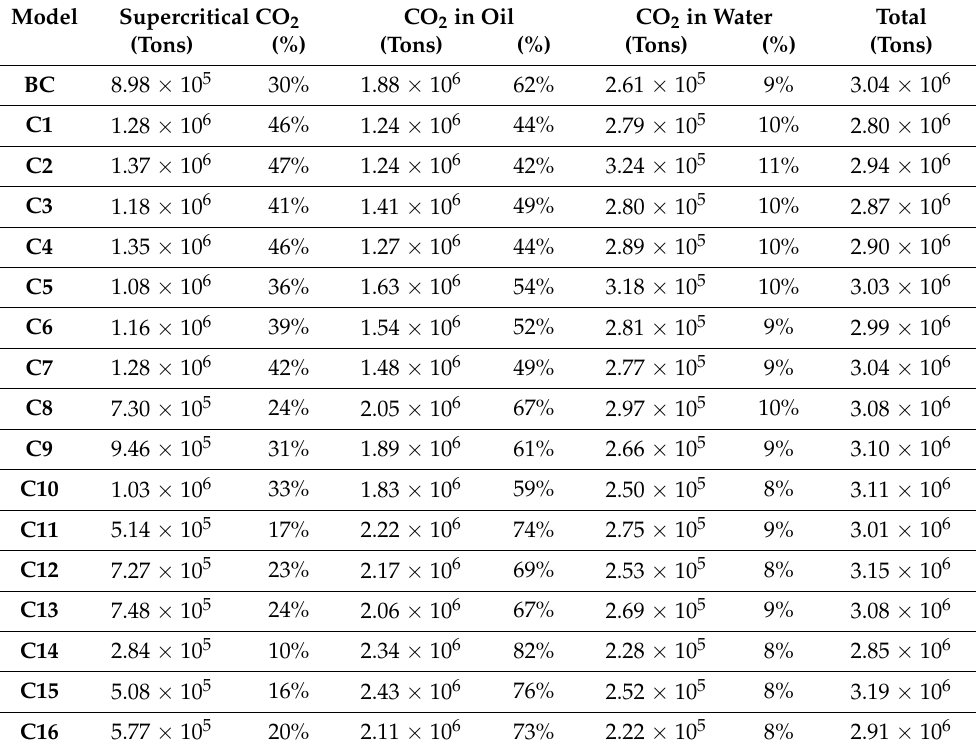
Table 3. The total mass of CO 2 stored in each phase; supercritical, dissolved in the oil phase, dissolved in the aqueous phase. These data are the totals for the end of the